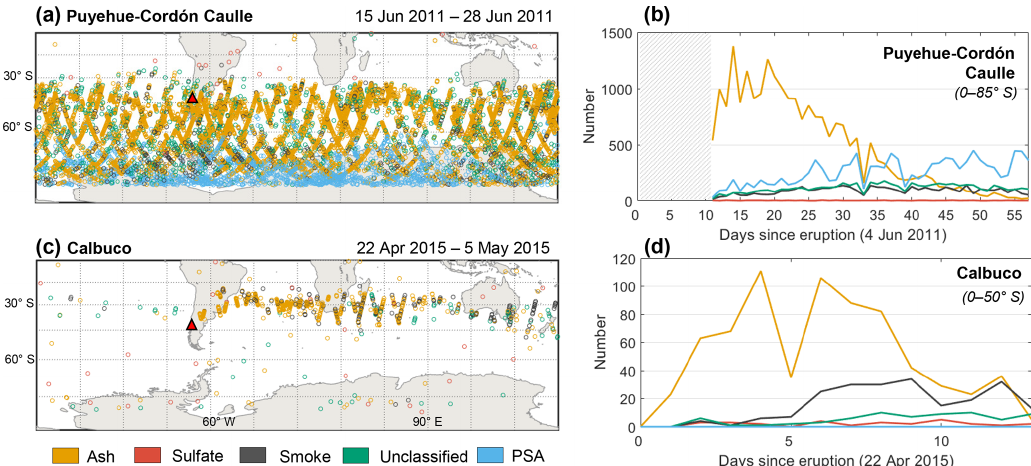
Figure 15. For ash-dominated events in V4.5: (a) locations of subtype classifications following first CALIOP detection, and (b) time history summation of subtype classifications. Volcano locations are denoted by red triangles. Hatched areas indicate missing CALIOP data. The payload was down for testing and spacecraft maneuvers during part of 27 April 2015, causing the reduced number of layer detections on that date in panel (d)